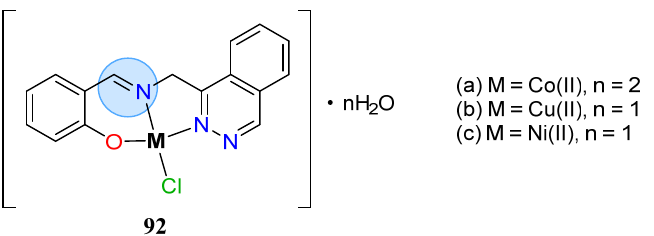
Figure 49. Metal(II) complexes with a tridentate hydrazone ligand derived from hydralazine with antimicrobial activity.